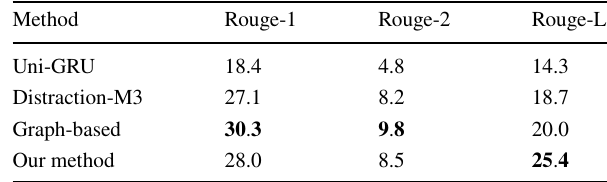
Table 6 Performance comparison of various abstractive models on the CNN test set using full-length F1 variants of Rouge